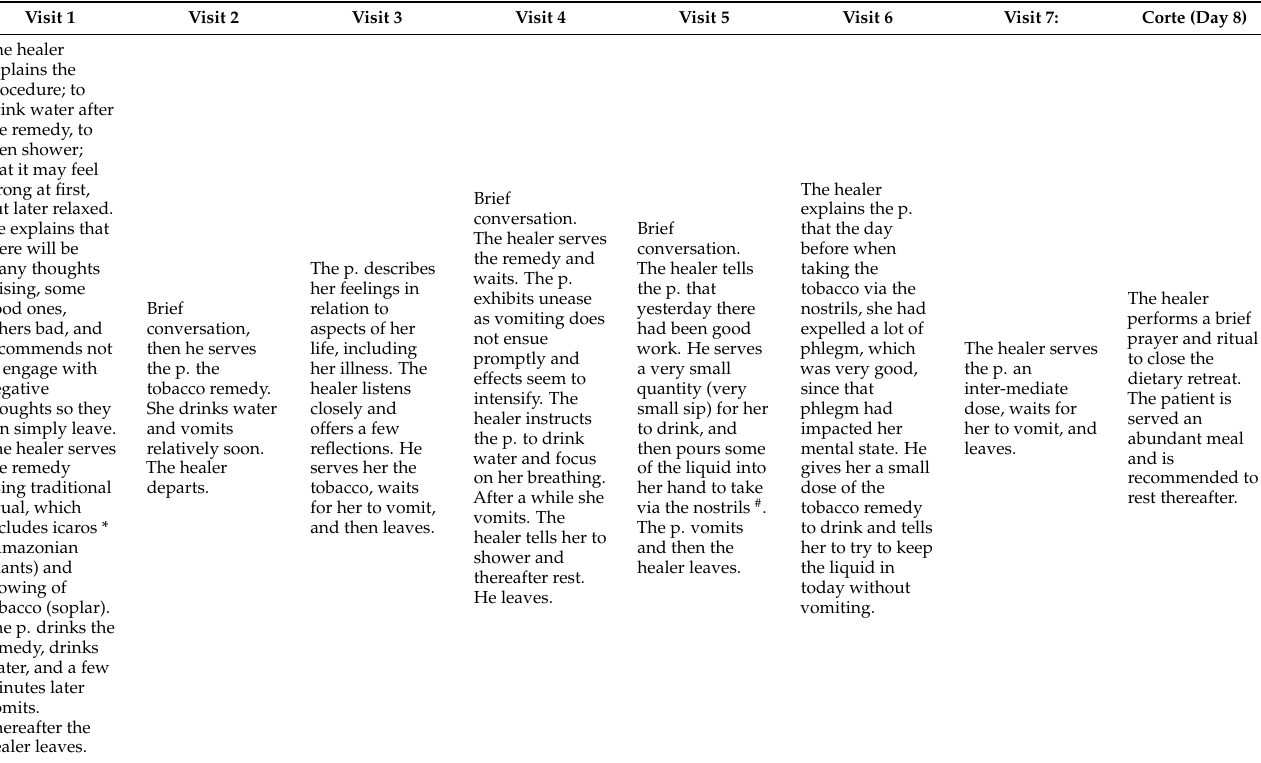
Table 1. Daily visits of the healer ( Tabaquero ) to